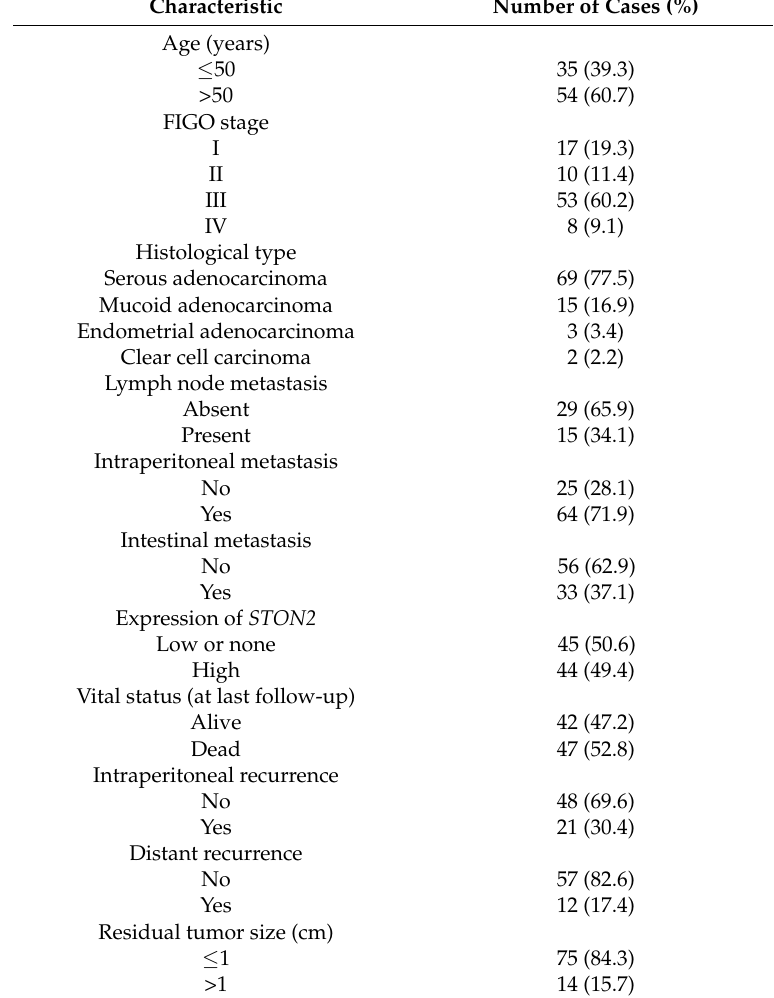
Table 1. Clinicopathological characteristics and tumor expression of STON2 in epithelial ovarian cancer.